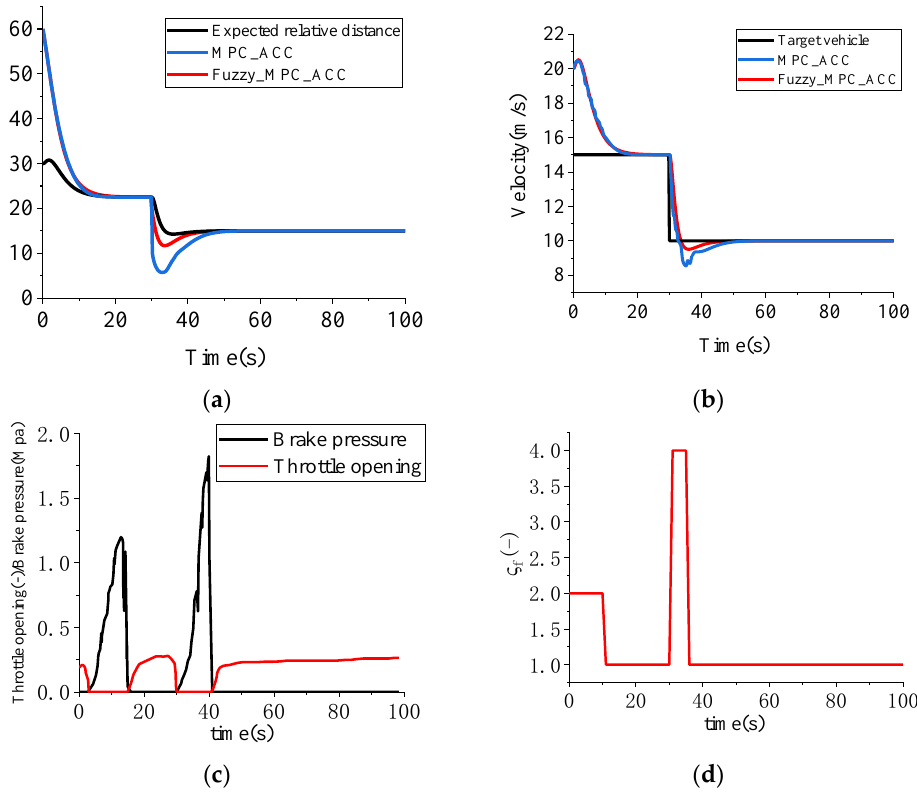
Figure 9. Target vehicle insertion: ( a ) speed; ( b ) relative distance; ( c ) throttle opening/brake pressure; ( d ) weight coefficient ς f